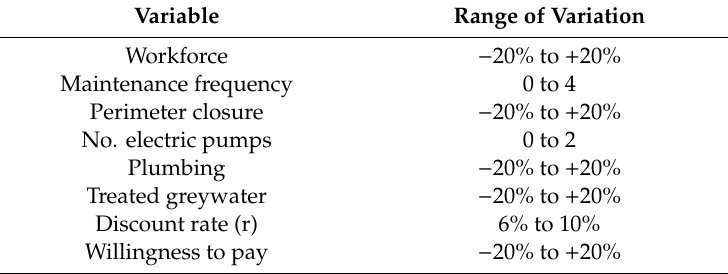
Table 3. Sensitivity analysis